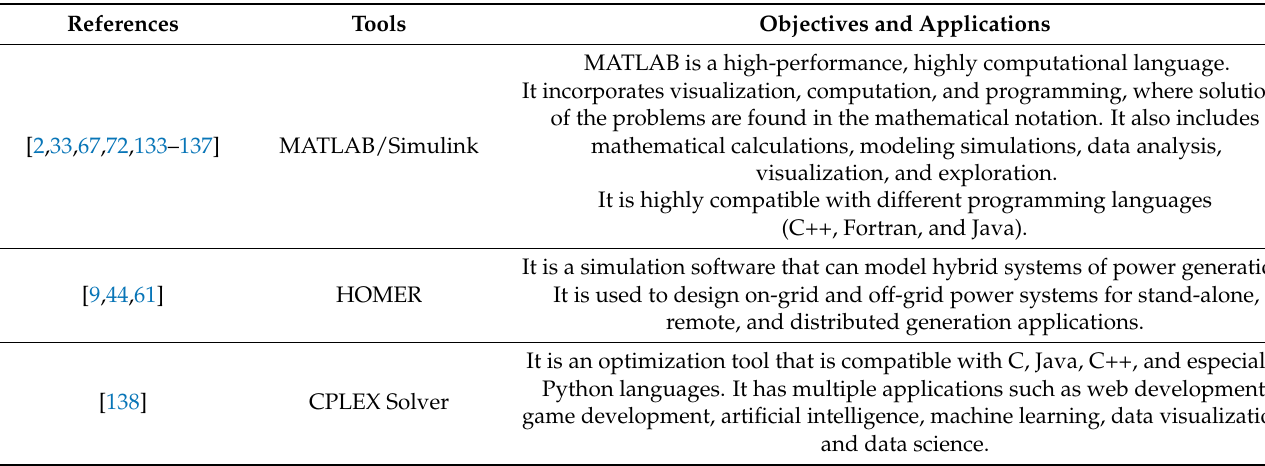
Table 5. Simulation software used in the energy management of campus